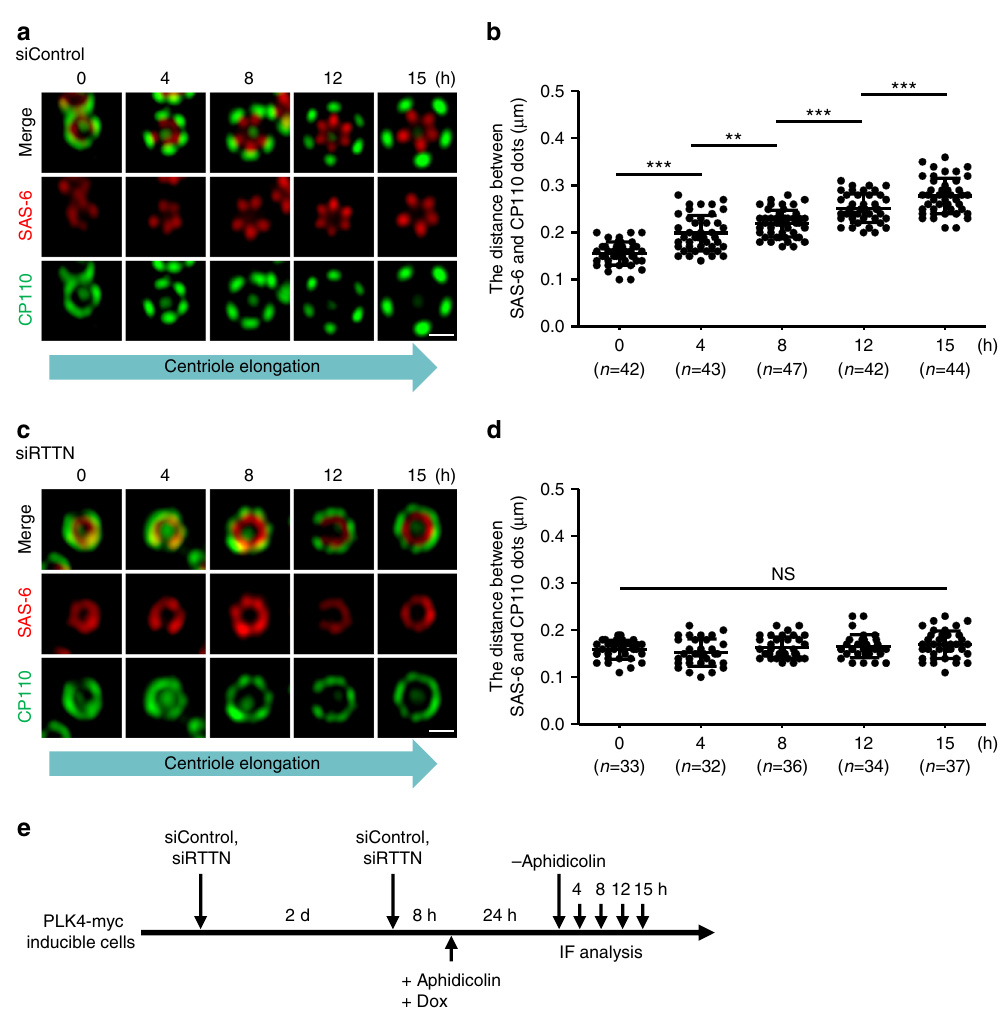
Fig. 2 Depletion of RTTN perturbs centriole elongation. PLK4-myc-inducible cells were treated with siControl a , b or siRTTN c , d as shown in e , and analyzed by confocal fl uorescence microscopy using the indicated antibodies. The procentriole length was measured as the distance between the fl uorescent peak intensity of SAS-6 ( red ) and CP110 ( green ) in siControl- a , b and siRTTN-treated cells c , d . Error bars represent the mean ± s.d.; ** P < 0.01; *** P < 0.001; NS, not signi fi cant (two-tailed t -test). Scale bar , 0.5 μ